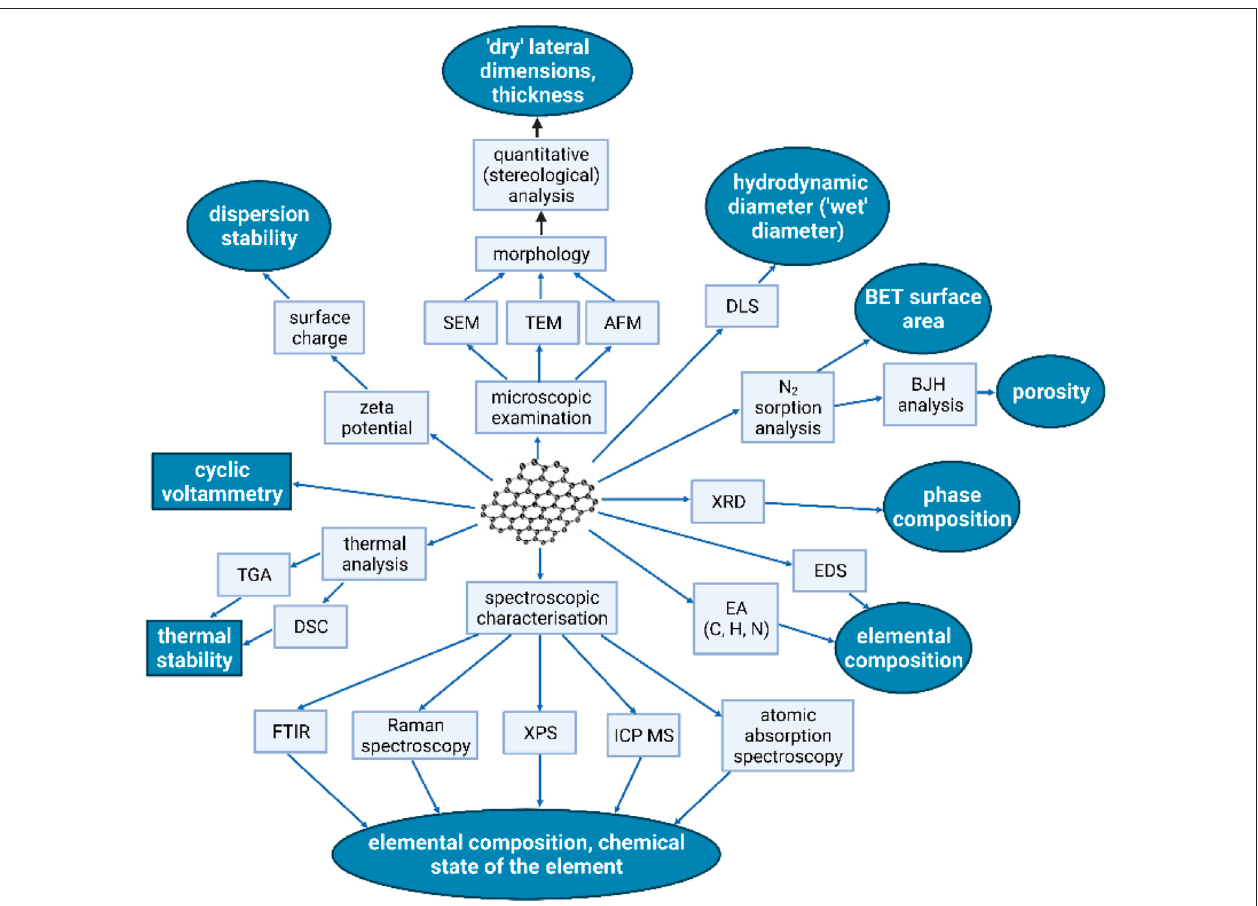
FIGURE8| Mostimportantmethodsandresearchtechniquesappliedinthecharacterizationofgraphene-familynanomaterials(GMFs).Fieldsmarkedingreycolor represent GFMs parameters directly linked to their bioactive properties. For simpli fi cation, the following abbreviations were used: TEM, transmission electron microscopy; SEM, scanning electron microscopy; AFM, atomic force microscopy; DLS, dynamic light scattering; FT-IR, Fourier-transform infrared spectroscopy; XPS, X-ray photoelectron spectroscopy; XRD, X-ray diffraction; BET, Brunauer – Emmett – Teller; BJH, Barrett Joyner, Halenda; EDS, Energy-dispersive X-ray spectroscopy; TGA, Thermogravimetric analysis; DSC, differential scanning calorimetry; ICP-MS, inductively coupled plasma mass spectrometry (Reproduced with permission from (Jastrze ˛ bska and Olszyna, 2015) with minor changes).